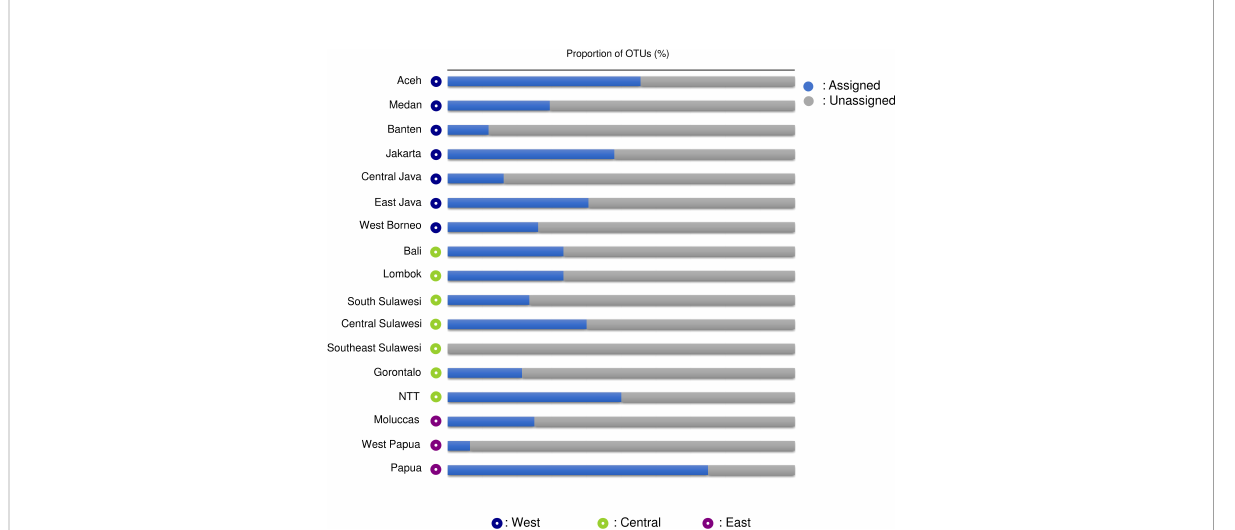
FIGURE 5 Bar chart showing the percentage of Operational Taxonomic Units (OTUs) assigned and unassigned to species level by province and by region (West, Central, and East